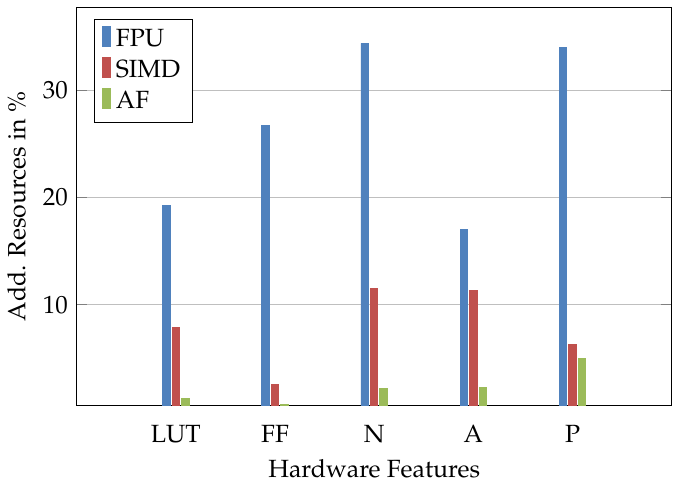
Figure 7. Accuracy ( blue ), sensitivity ( red ), specificity ( green ) and F1-Score ( purple ) for the different versions of the MicroNet.